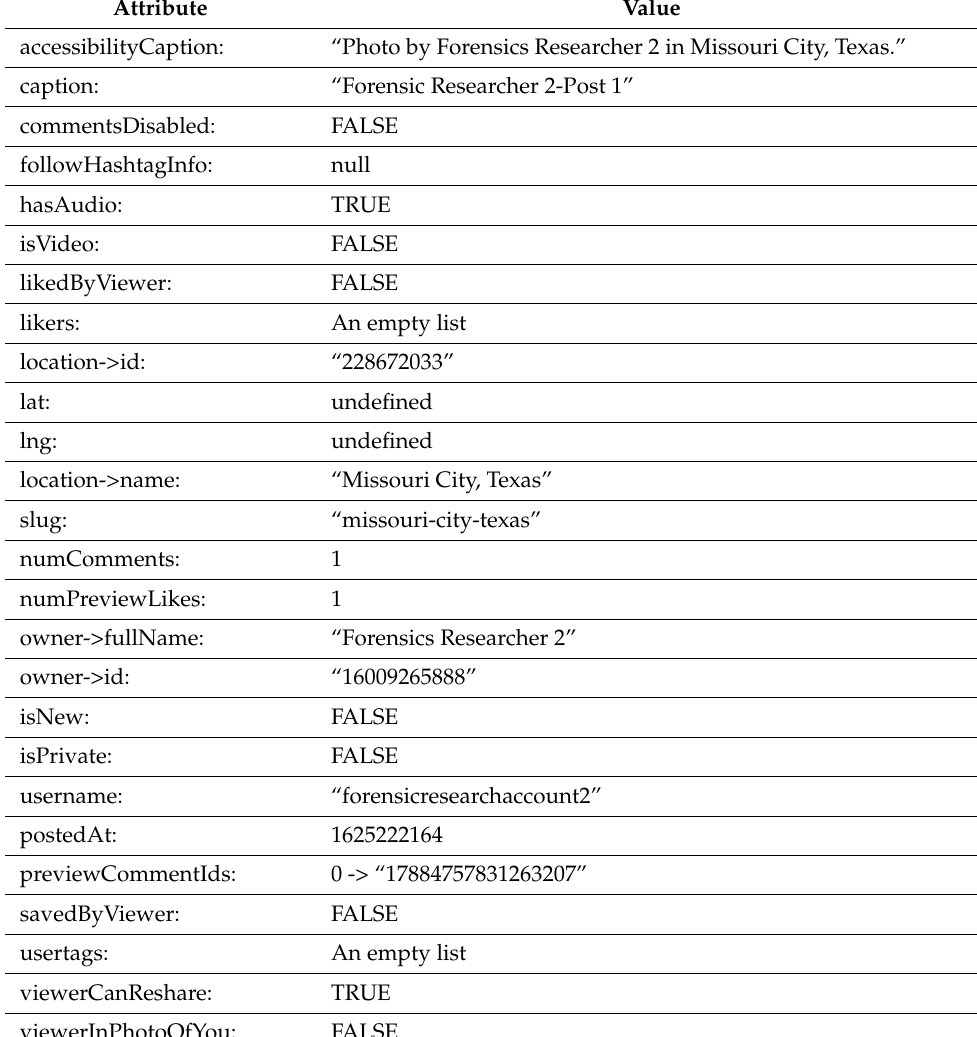
Table 9. Artifacts Found in posts.byId